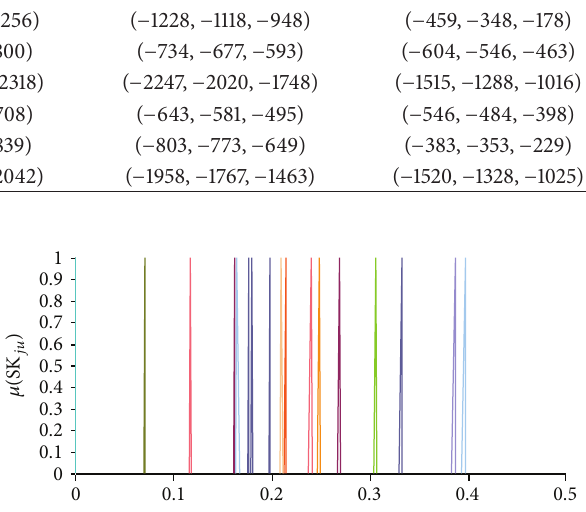
Figure 6: The fuzzy slacks of the 19 jobs after optimization.